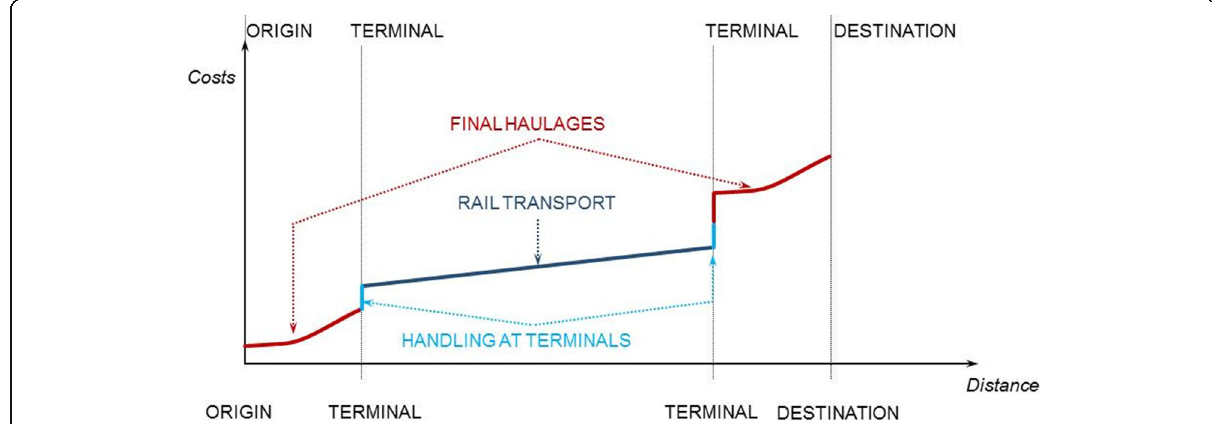
Fig. 3 Cost scheme showing the structure of costs for combined transport